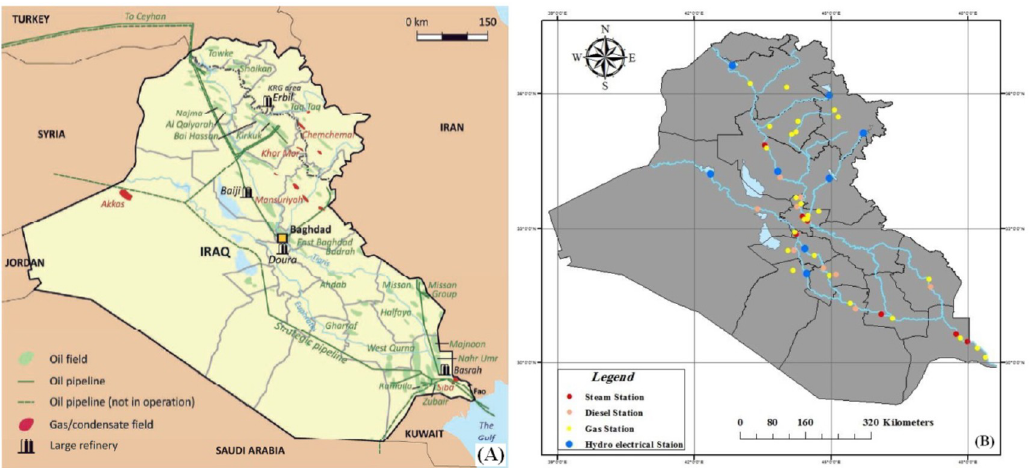
Figure 1. ( A ) Iraq hydrocarbon resources and infrastructure; ( B ) types of electrical energy production stations in Iraq (steam, diesel, gas, and hydro-electrical stations).